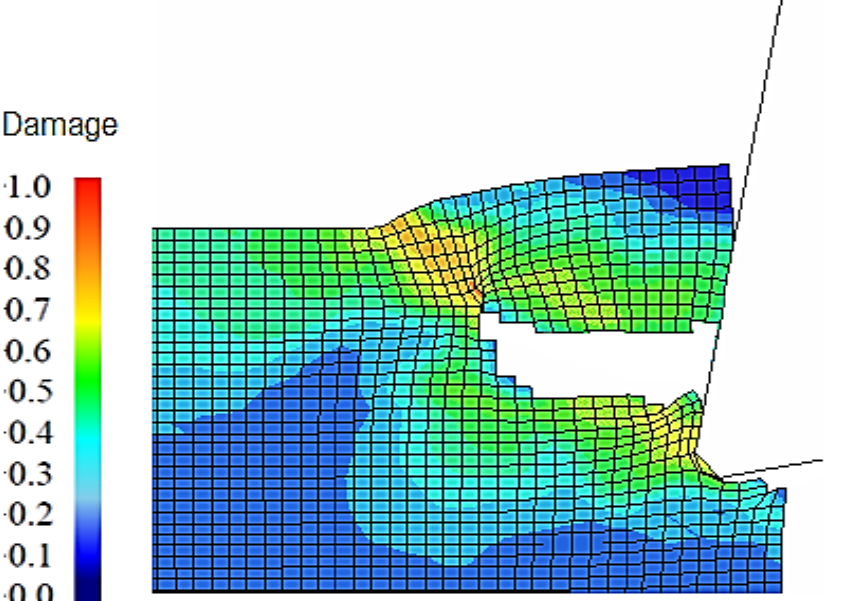
Figure 15. Distribution of damage parameter D .